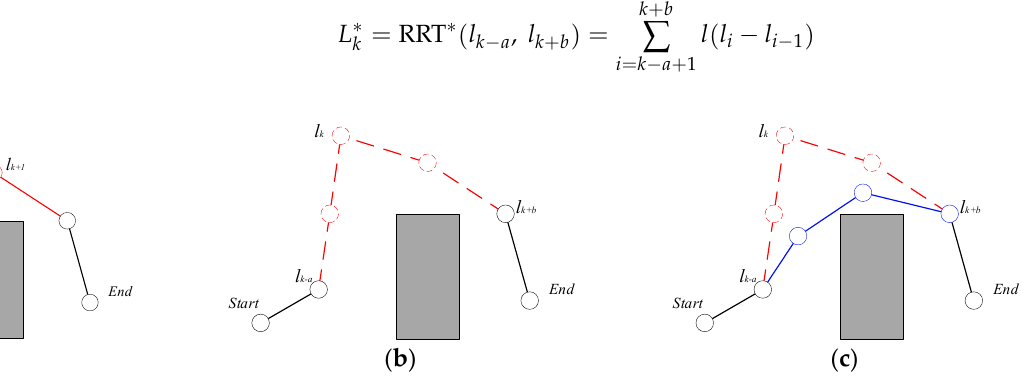
Figure 3. Illustration of dual RRT optimization. In ( a ), the initial path obtained by RRT-connect has a large corner; in ( b ), select the nodes near the corner as the path to be optimized; in ( c ), replace the path to be optimized with the path regenerated by RRT*.